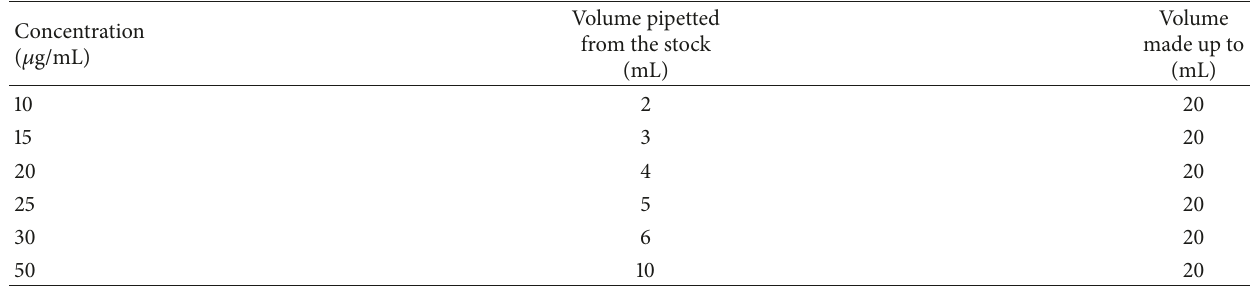
Table 1: Preparation of standard solutions for the evaluation of linearity.